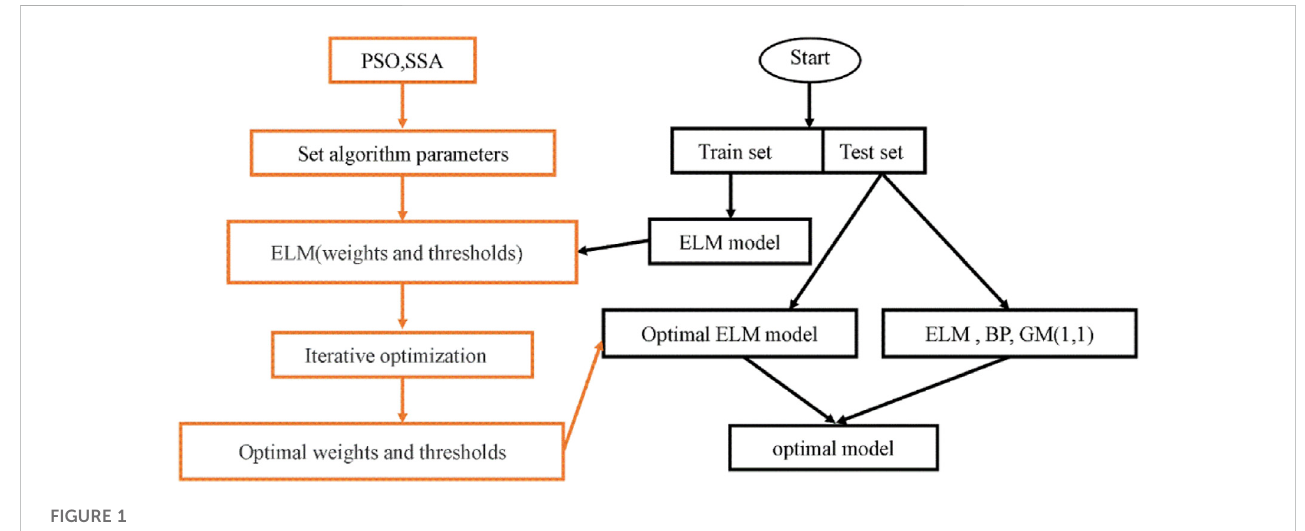
FIGURE 1 Flow chart of SSA-ELM and PSO-ELM